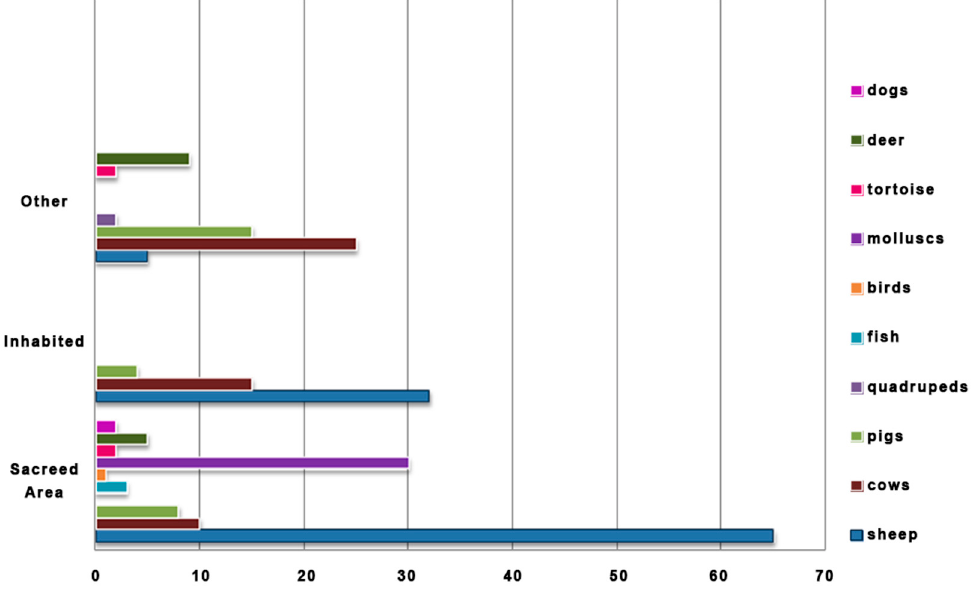
Figure 26. Percentages of animal remains per type, as excavated in different areas of Motya.